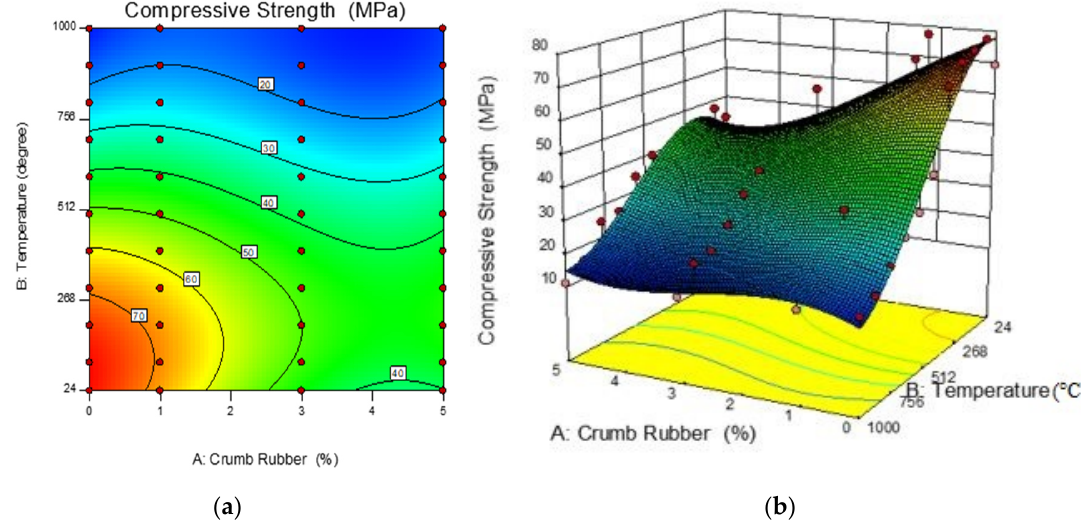
Figure 4. Response surface diagrams for the residual compressive strength of CR-ECC. ( a ) 2D contour plot; ( b ) 3D surface diagram.